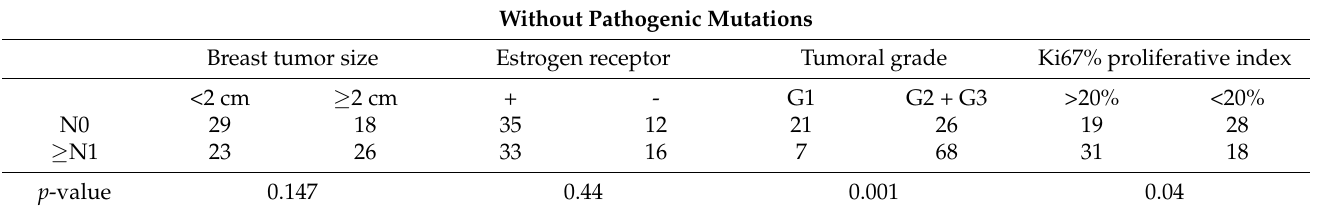
True positive = patients with suspect US confirmed by surgery; true negative = patients with no metastatic lymph nodes confirmed by histology; false negative = patients with no suspect lymph nodes on US, but with surgery-proven metastasis; false positive = patients with abnormal US lymph nodes with no histology-proven metastasis.